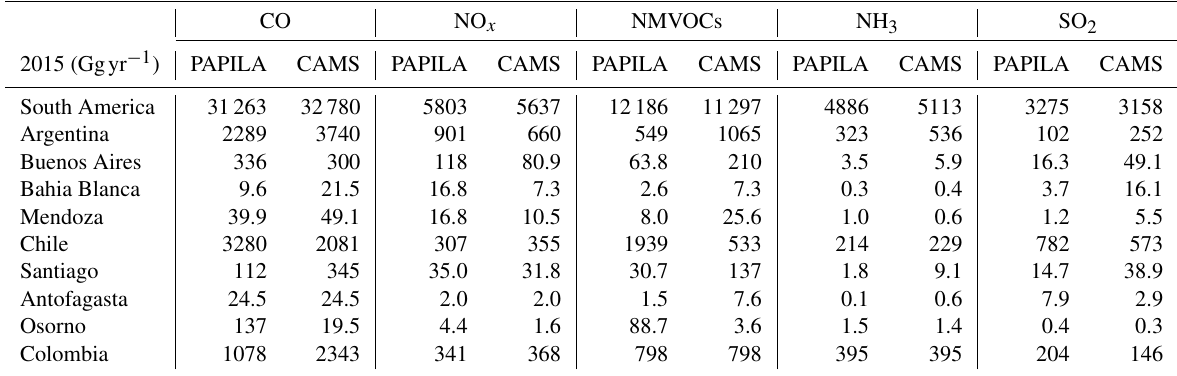
Table 2. Summary of annual emissions by domain for 2015 (Ggyr − 1 ). CO NO x NMVOCs NH 3 SO 2 2015 (Ggyr − 1 ) PAPILA CAMS PAPILA CAMS